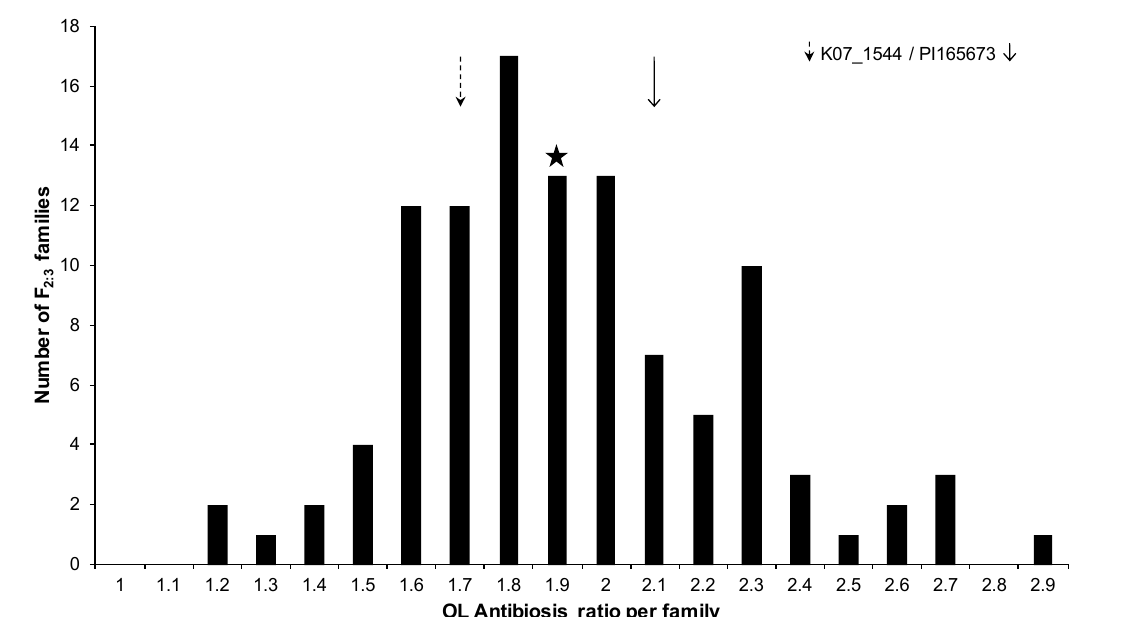
Figure 5. Frequency distribution of the OL antibiosis ratio in plants from 108 F 2:3 families from the cross K07-1544/PI165673 at 21 post infestation with Dectes texanus in 2012. OL antibiosis ratio (number of oviposition punctures/number of larvae). Arrows and star indicate parent and F 2:3 population mean, respectively.